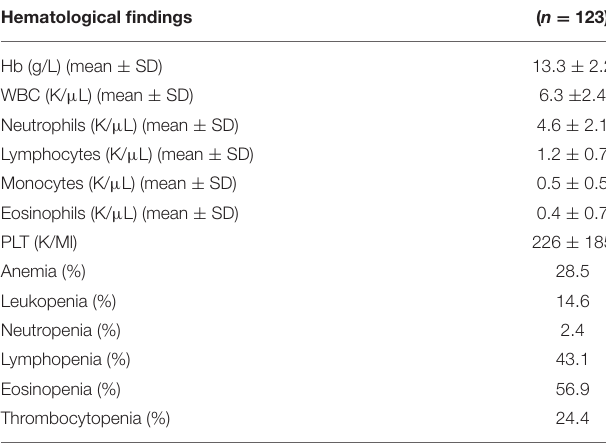
TABLE 1 | Prevalence of hematological abnormalities among the 123 study participants. Hematological